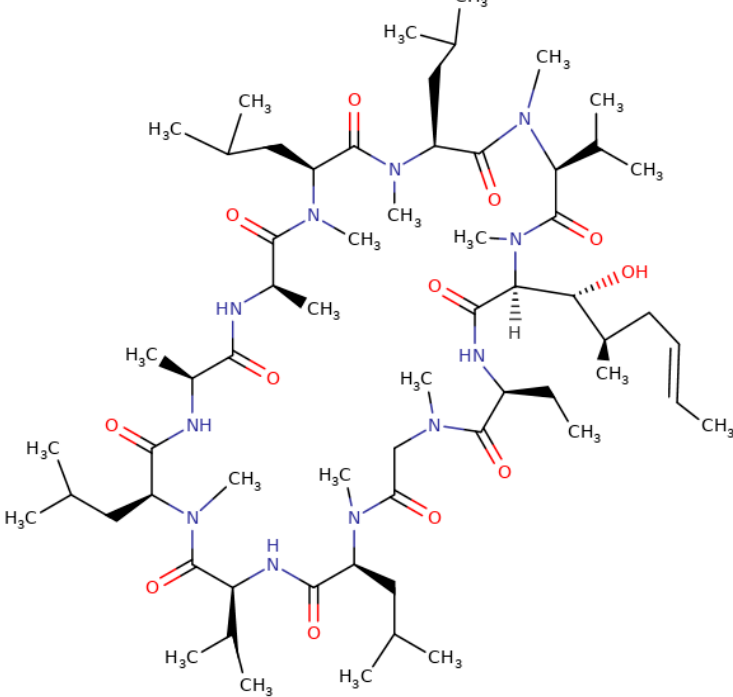
Figure 1. Cyclosporine A (CsA) structure.